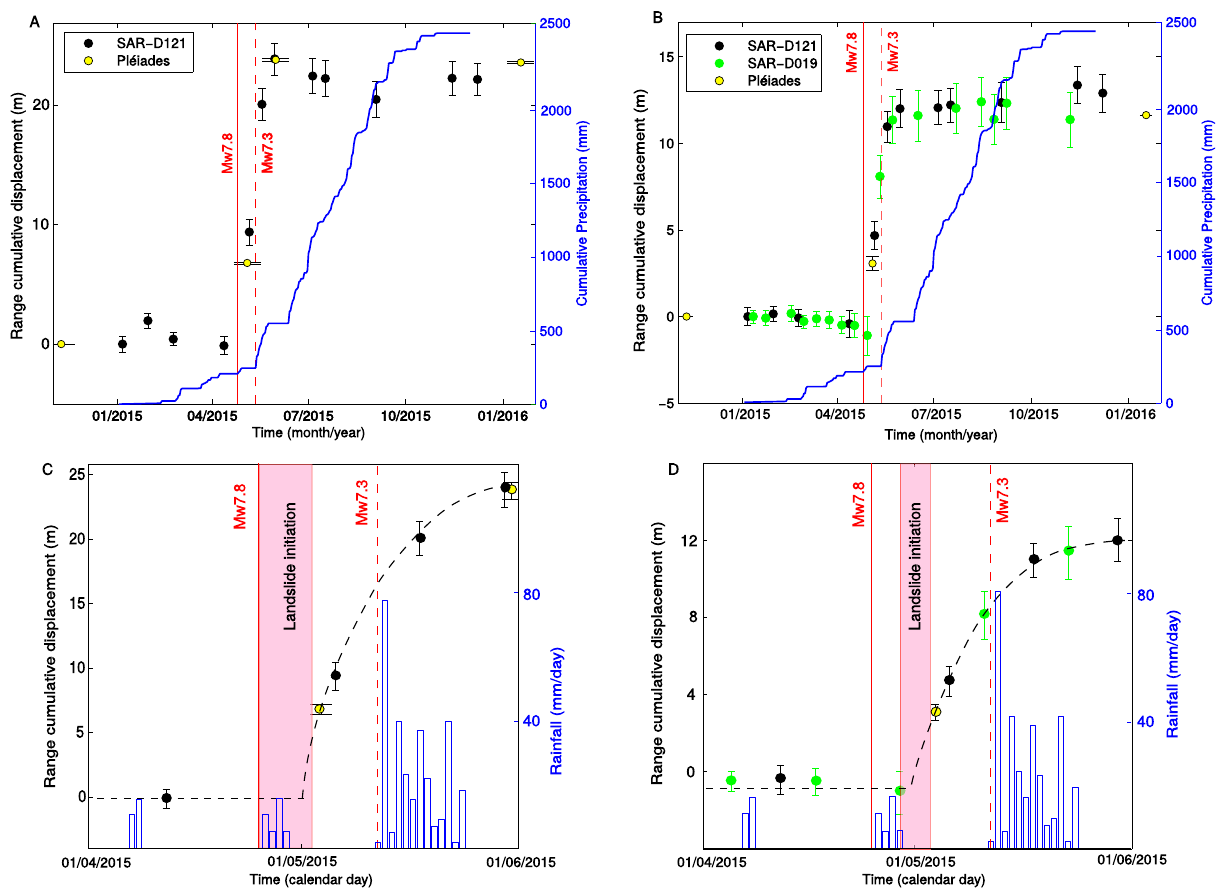
Figure 5. Time-series of landslide displacements along the SAR range direction for Duguna Gadi ( A , C ) and Tapgaon landslides ( B , D ) from both Pléiades (yellow dots) and SAR (black and green) image correlations at the locations defined in Fig. 4. The blue curve shows the cumulative rainfall as measured by the rain gauge of Bahrabise (see location on map of the Fig. 2) with a daily frequency. The panels ( C ) and ( D ) show a zoom on the two months around the Gorkha earthquake for the two same landslides. The red zone highlights the possible initiation time for the landslide motion. A logarithmic function is also fitted to the post-seismic motions to better estimate this initiation time (dashed black